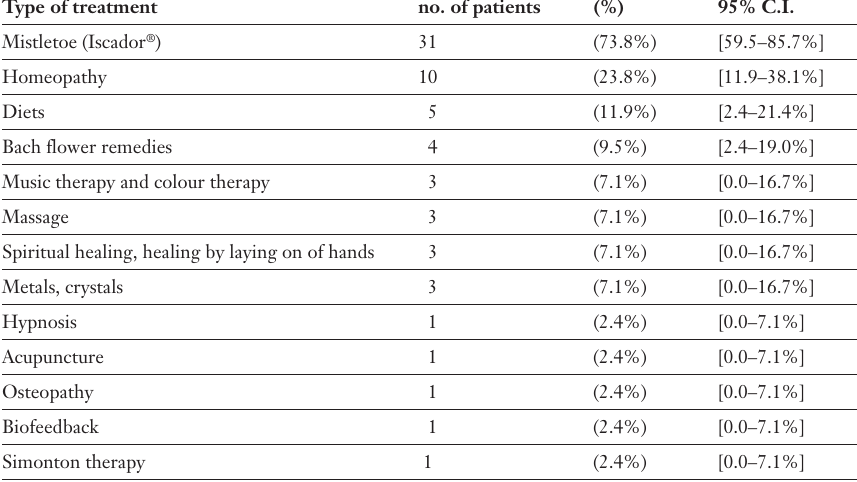
Comparison of the prevalence of using alternative cancer treatment and the types of treatment in different studies carried out in Switzerland (all figures in